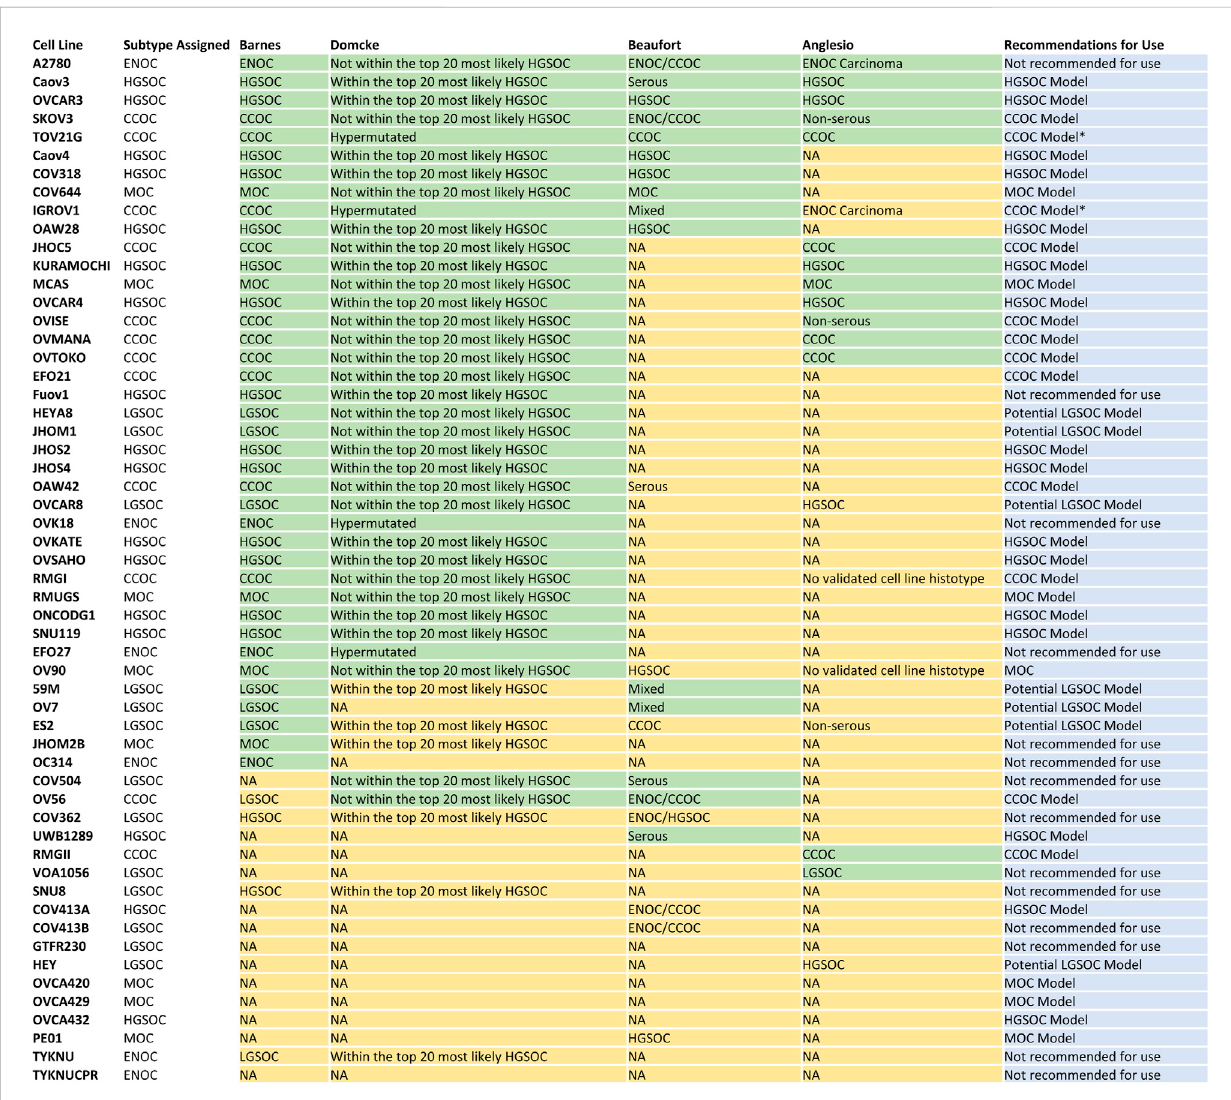
FIGURE 6 Consensus table displaying cell line subtype classi fi cation in this study, Barnes et al. (2021), Domcke et al. (2013), Beaufort et al. (2014) and Anglesio et al. (2013), and recommendations for future use. Overall, there are 16 models of HGSOC, 12 models of CCOC and seven models of MOC. Seven lines represent potential models of LGSOC, although further comparisons to tumor samples are needed to con fi rm this. Fourteen lines should be avoided in future in vitro and in silico studies due to i) poor correlation to EOC tumors overall (A2780, OVK18, OC314, EFO27, TYKNU, TYKNUCPR), ii) classi fi cation as a certain subtype but displaying poor correlation to respective primary tumors (Fuov1, JHOM2B), iii) high correlations to multiple EOC subtypes (SNU8), iv) classi fi cation as LGSOC but displaying high correlations to other EOC subtypes (COV504, VOA1056, COV413B, COV362) and GTFR230 due to origination from a MOC tumor but classi fi cation as LGSOC. *Caution should be taken when utilizing TOV21G and IGROV1 as models of CCOC due to their hyper mutated